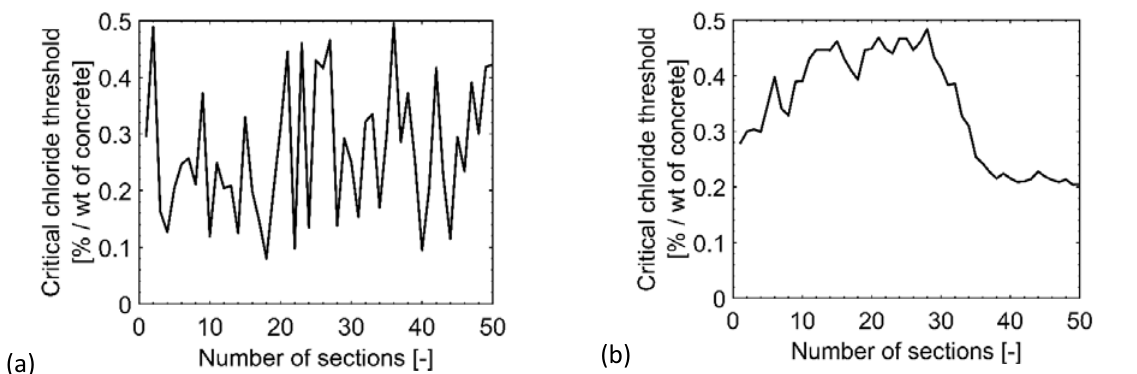
Figure 8. Distribution of initial chloride threshold values along the length of a single rebar. (a) using a random distribution, and (b) using a more realistic, multi ‐ variate uniform random